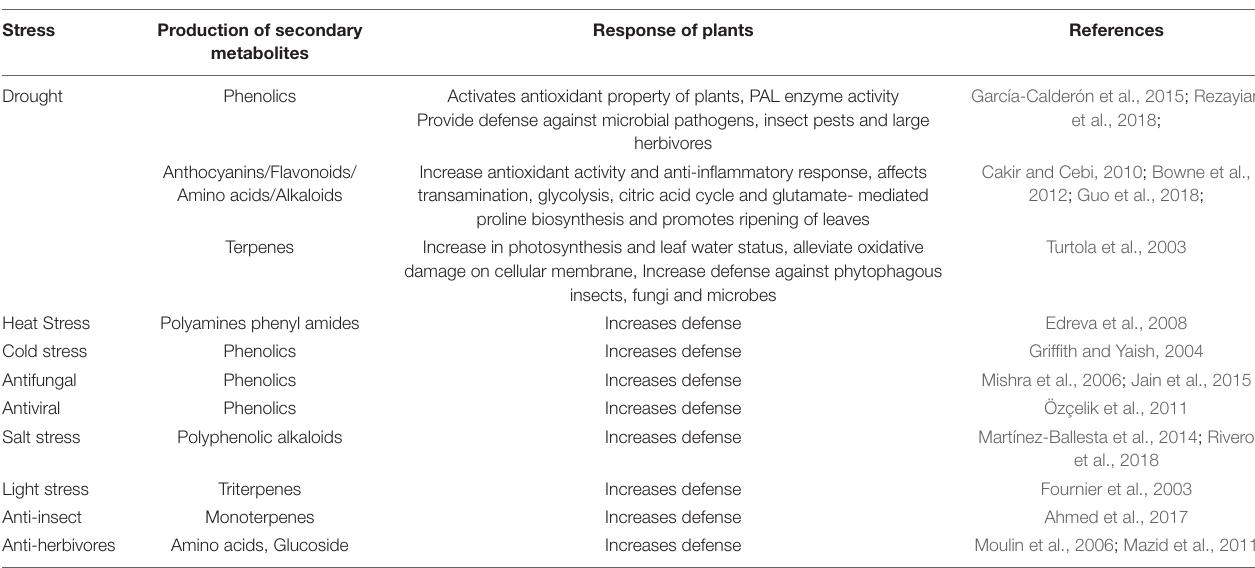
FIGURE 8 | Effect of abiotic stress on plant’s normal physiological functions, activation of phytohormones and response of plant to stress: Story of stress tolerance in plants. TABLE 3 | Enhancement of secondary metabolites under stress to cope with stressed conditions in